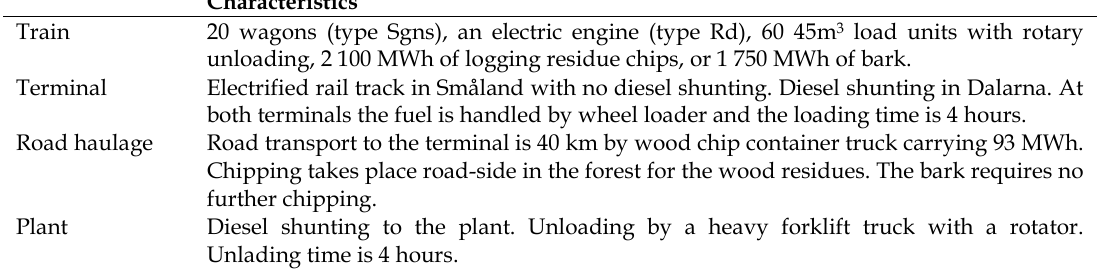
Table 2. Base scenario characteristics